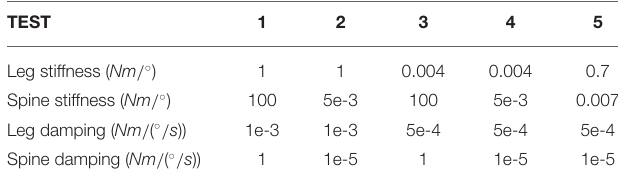
TABLE 2 | Stiffness and damping for the five tests performed.